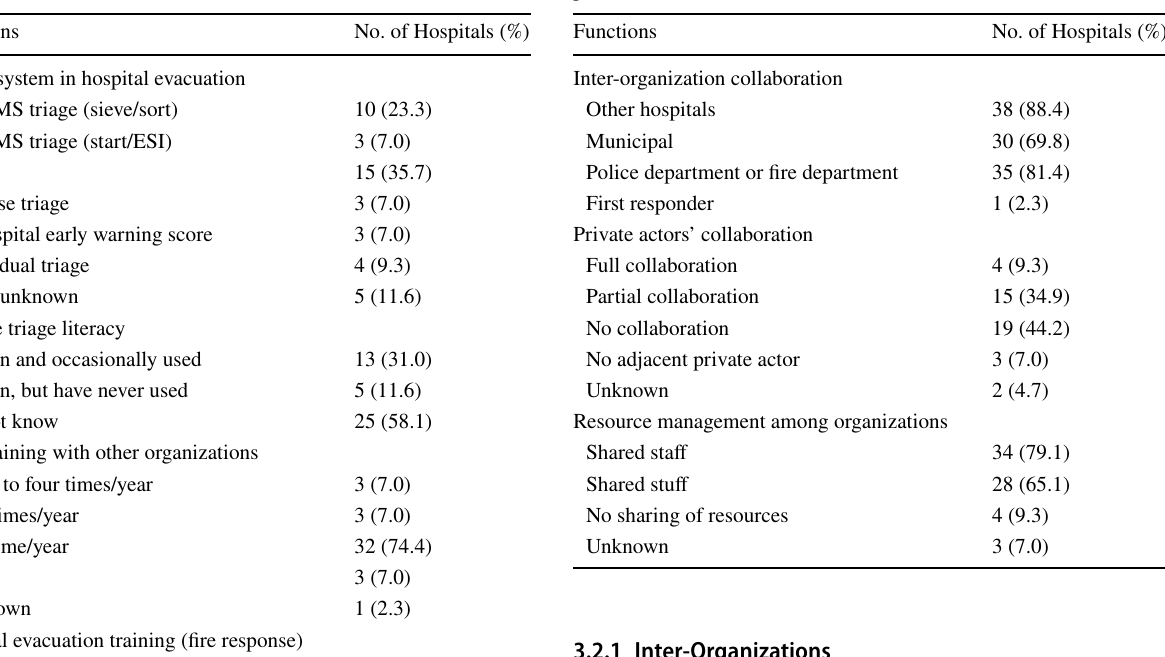
Table 4 Collaborations regarding hospital evacuation in 43 Thai